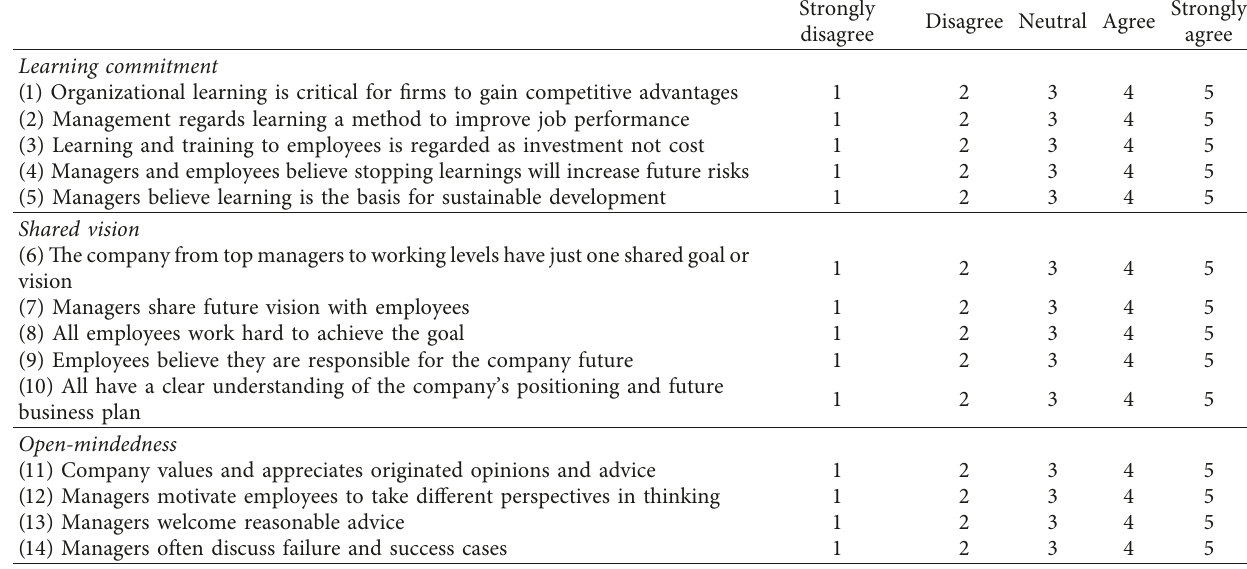
Table 9: Questions for organizational learning.